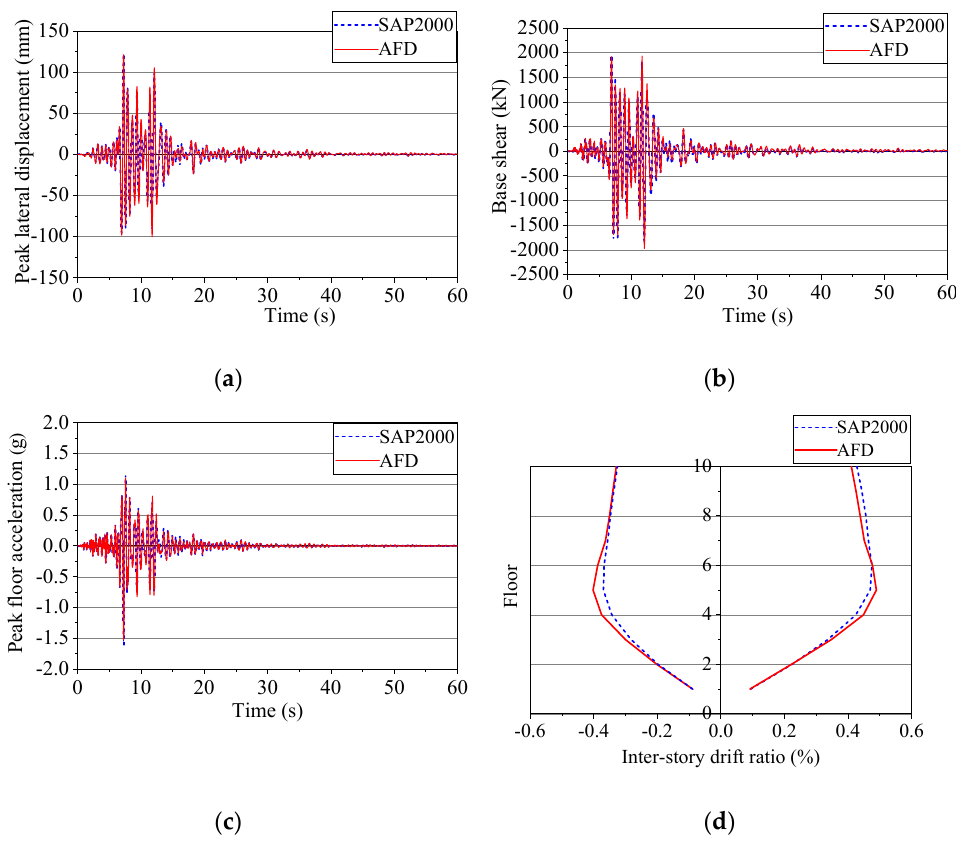
Figure 18. Responses of coupled shear wall structure: devices at floor 3 to 5: ( a ) Peak lateral displacement; ( b ) Base shear; ( c ) Peak floor acceleration; ( d ) Inter-story drift ratio.